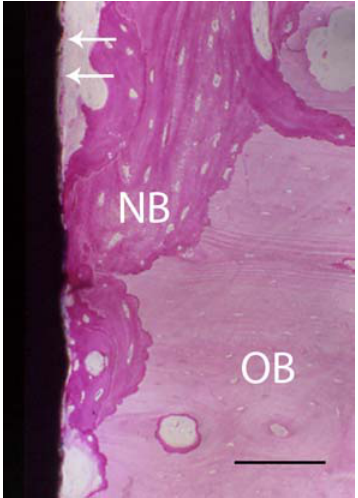
FIGURE 9 . LM image of Zr-SLA screw 3 months after surgery. Newly formed peri-implant mature lamellar bone in direct contact with the implant surface (NB). Older bone (OB). Small marrow spaces with blood vessels are in direct contact with the metal. In these regions a line of rounded cells appear to intimately hold on the titanium surface (arrows). Bar = 100 µm